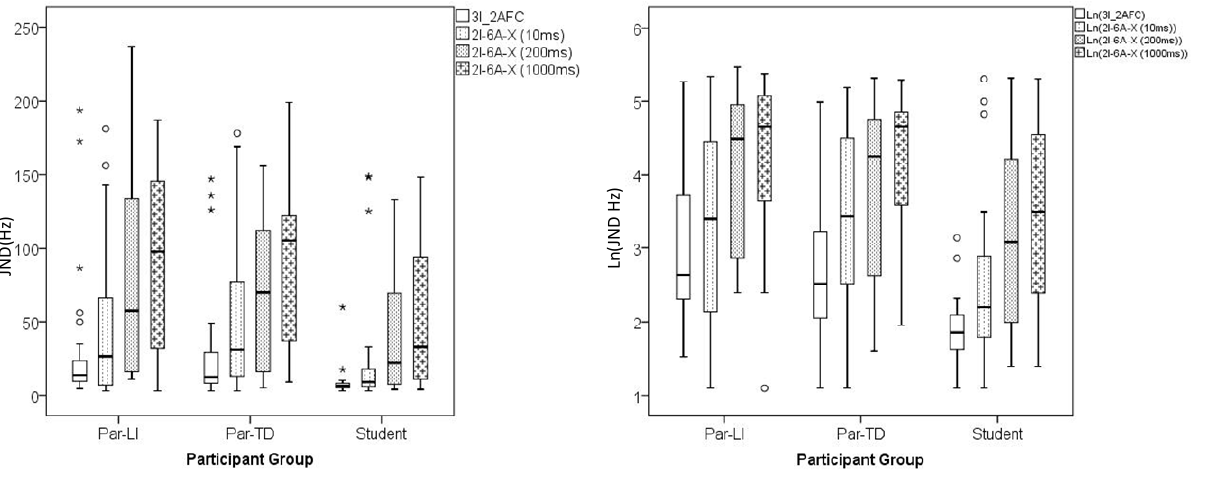
Figure 1. Box plot summaries of JNDs for the three groups of participants on the two psychophysical tasks. The left panel presents the raw data, while the right shows the transformed data. In the boxes, the black bars indicate median scores. The top to bottom edges of the boxes incorporate the interquartile range of performance, with the whiskers indicating the range of scores observed for each measure. Outliers are identified as falling outside 1.5 ( ○ ) and 3 (*) times the box length from the upper or lower edges of the boxes.